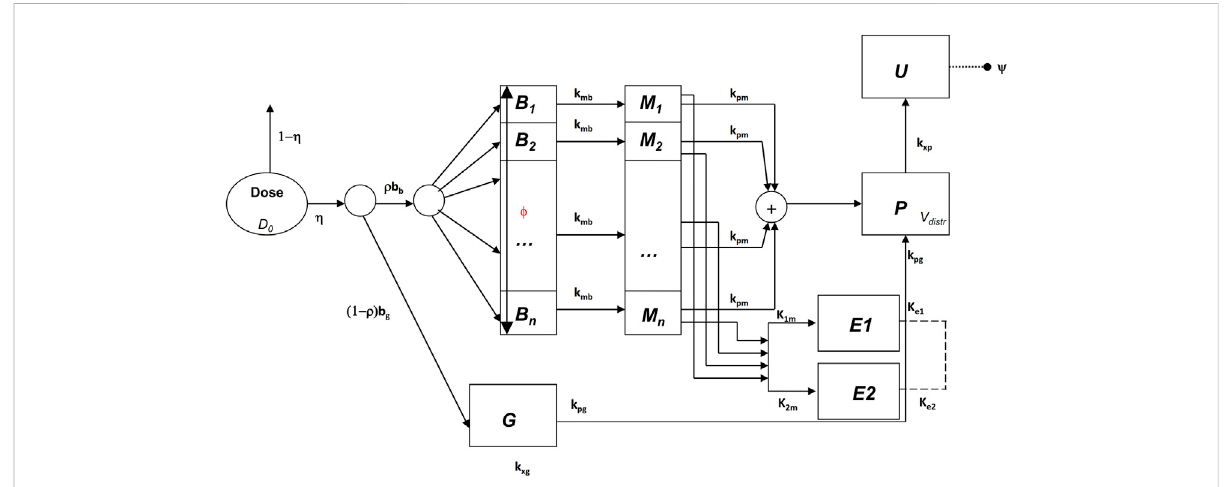
FIGURE 1 Schematic representation of the pharmacokinetic/pharmacodynamic